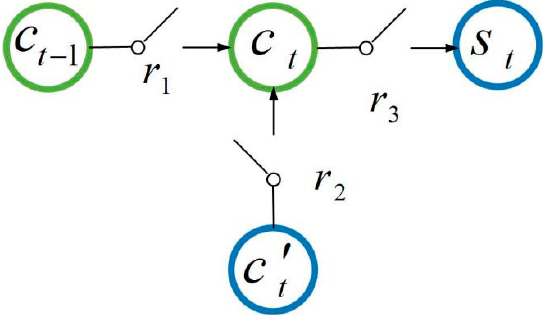
Figure 4. Three gates of the LSTM network. Figure 3. Schematic diagram of the hidden layer of the LSTM neural network.